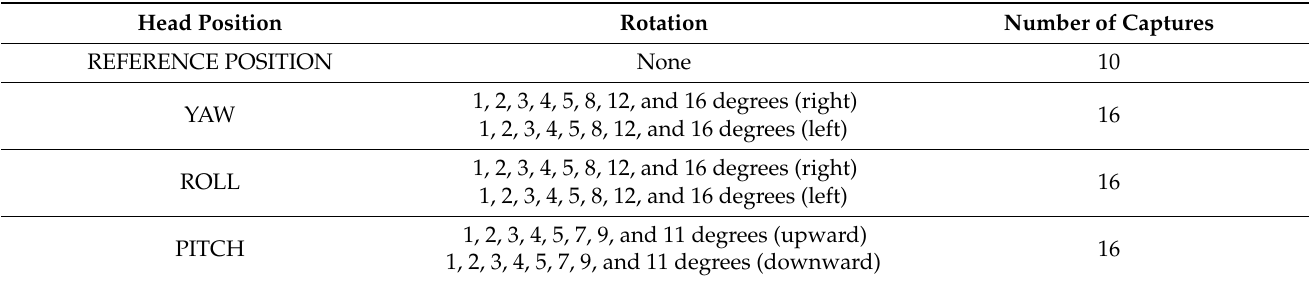
Table 1. The protocol of image acquisition reported the 58 captures that were taken as follows: 10 captures with the mannequin head with no rotation (0 degrees), defined as reference position; 16 captures with the mannequin head rotated at different degrees of yaw, respectively 1, 2, 3, 4, 5, 8, 12, and 16 degrees, both on right and left; 16 captures with the mannequin head rotated at different degrees of rolls, respectively 1, 2, 3, 4, 5, 7, 9, and 11 degrees, both on right and left; 16 captures with the mannequin head rotated at different degrees of pitch, respectively 1, 2, 3, 4, 5, 7, 9, and 11 degrees, both upward and downward.